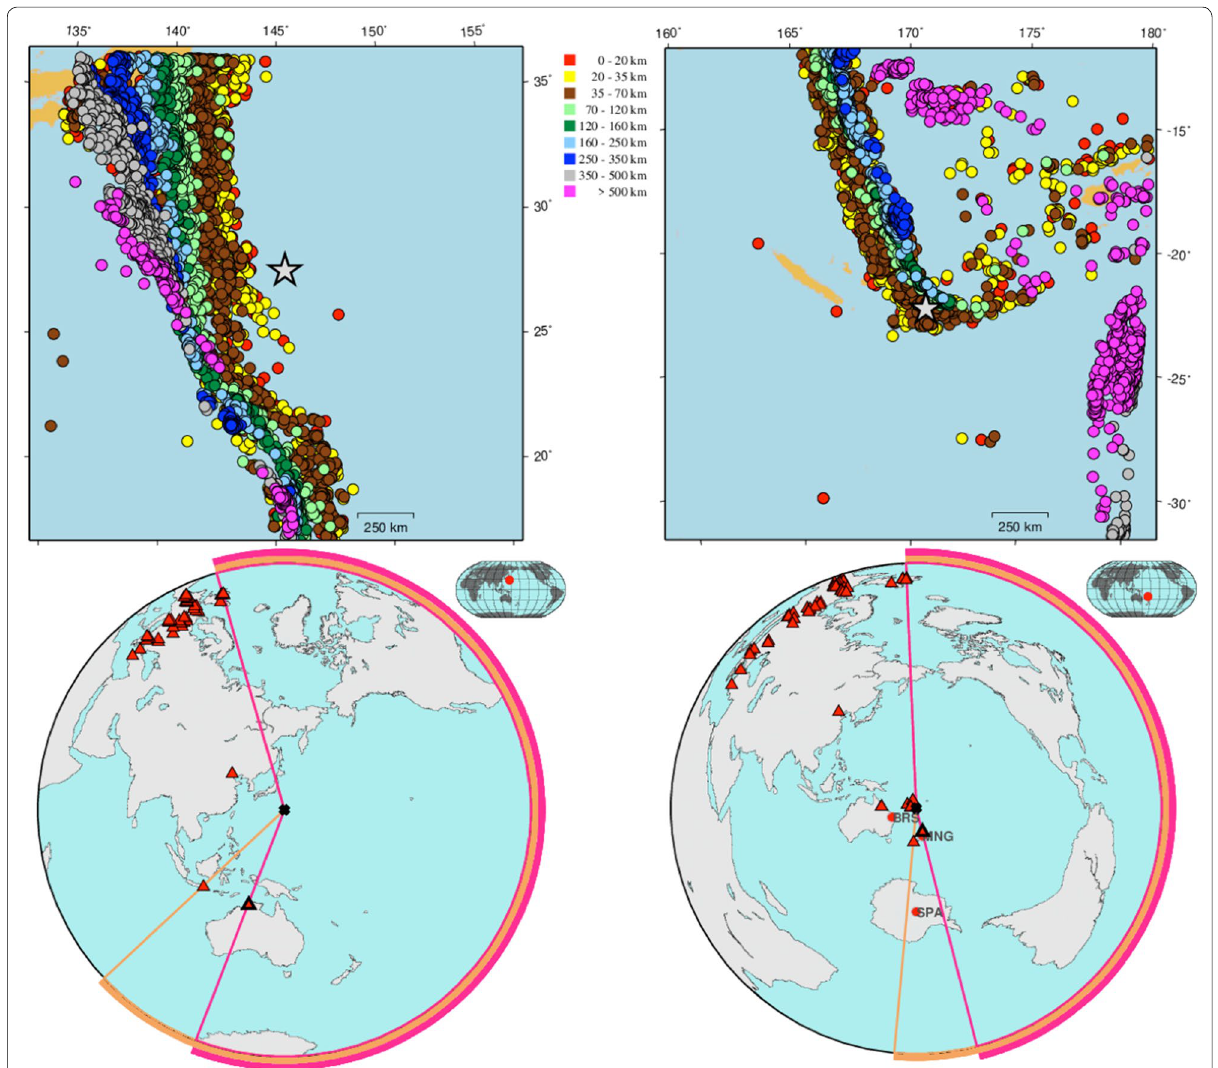
Fig. 6 The epicentre (denoted with a star) and stations that supported an alleged mb ISC 5.5 event in North Pacific Ocean on July 9, 1983 in the original ISC Bulletin (left); following a re-association of all available station data during the Rebuild project, the epicentre was moved by 6197 km to Southeast of Loyalty Islands (right). Pink and orange arcs indicate the primary and secondary station azimuthal